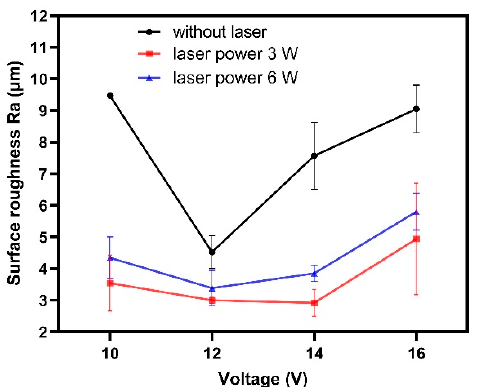
Figure 9. Variation of the surface roughness of the microgrooves processed by laser and shaped tube electrochemical milling with voltage and laser